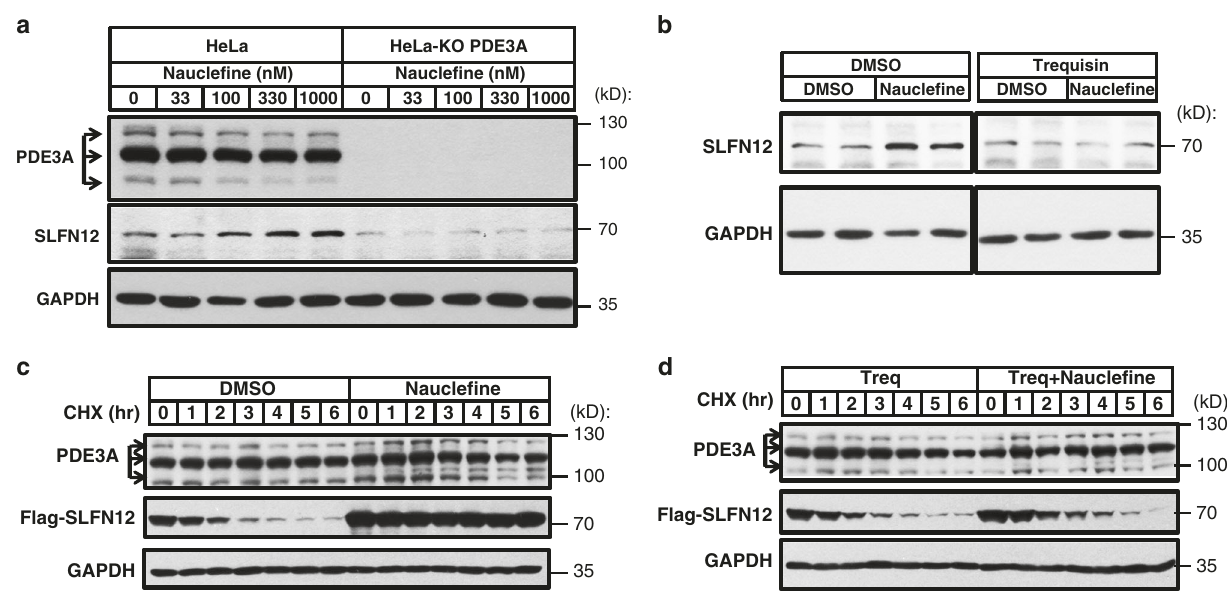
Fig. 5 Naucle fi ne caused increased SLFN12 protein stability. a Indicated concentrations of naucle fi ne were used to treat HeLa or PDE3A-KO HeLa cells for 24 h, then cells were collected for western blot analysis. b Naucle fi ne (250 nM) or naucle fi ne (250 nM) plus trequinsin (50 nM) were used to treat HeLa cells for 24 h, then cells were collected for western blot analysis. Naucle fi ne (200 nM) ( c ) or naucle fi ne (200 nM) plus trequinsin (50 nM) ( d ) were used to treat into Flag-SLFN12 stable cells for 24 h. Treq denotes trequinsin. Cells were then treated with 100 µ g/mL CHX for the indicated times and subjected to western blot analysis. The western blots are representative of results from two independent